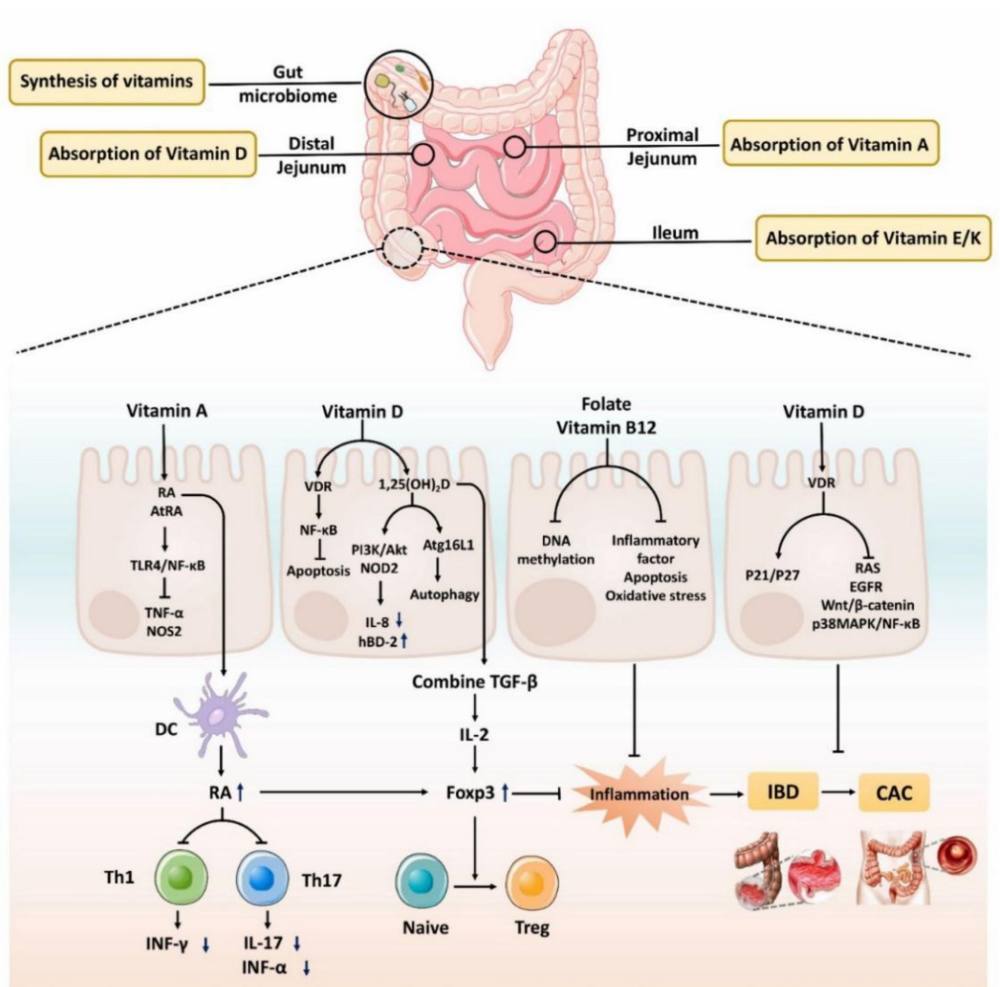
Figure 1. Intestinal absorption of vitamins and the mechanism of action of vitamins in inflammatory bowel disease (IBD), and colitis-associated colorectal cancer (CAC). The up and down arrows in Figure 1 represent increase and decrease, respectively. DC represent dendritic cell, which is the most functional professional antigen-presenting cells in the body. RA stands for retinoic